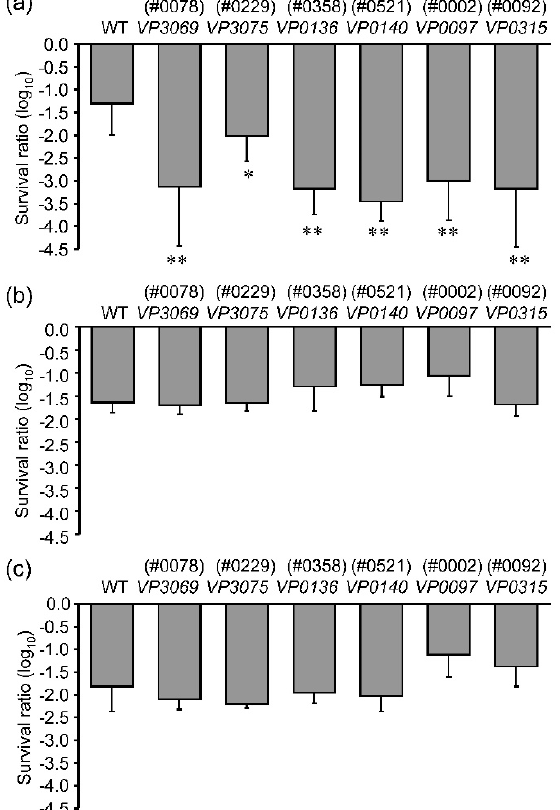
Figure 3. Sensitivities of six V. parahaemolyticus mutants to different wavelengths of UV light. ( a ) Responses to UVA-LED irradiation at 126 kJ / m 2 , ( b ) responses to UVB at 0.27 kJ / m 2 , ( c ) responses to UVC at 0.063 kJ / m 2 . The sensitivities to UV irradiation were presented as a logarithmic (log 10 ) analysis of the survival ratio as described in the materials and methods. The detailed emission spectra of UVA-LED, UVB, and UVC are shown in Supplementary Material Figure S1. Values shown are means ± SD; n = 3–6, where n = number of independent replicates. * p < 0.05 or ** p < 0.01 versus WT.